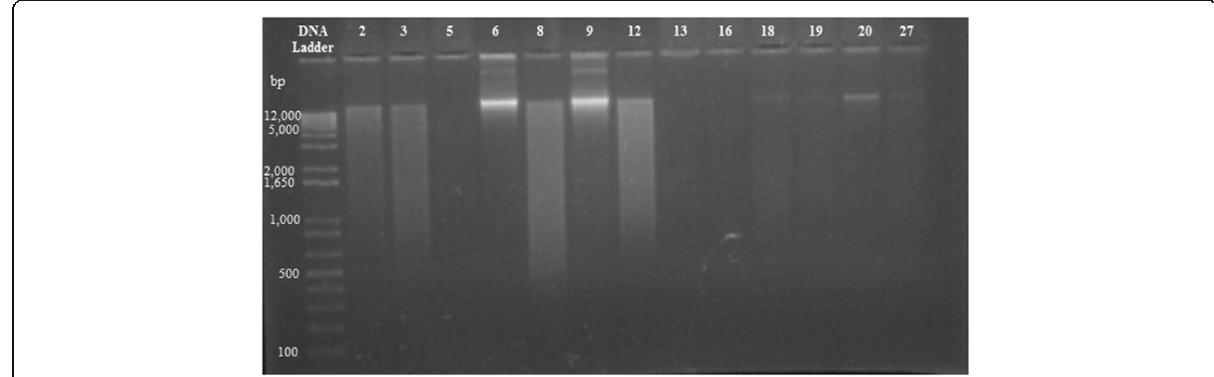
Fig. 1 DNA Plasmid electrophoresed on 1.5% agarose gel. Lane 1: DNA Ladder. DNA Plasmid 12,000 bp instrains2 (Lane 2), 3 (Lane 3), 6 (Lane 5), 8 (Lane 6), 9 (Lane 7), 12 (Lane 8) and 20 (Lane 13)